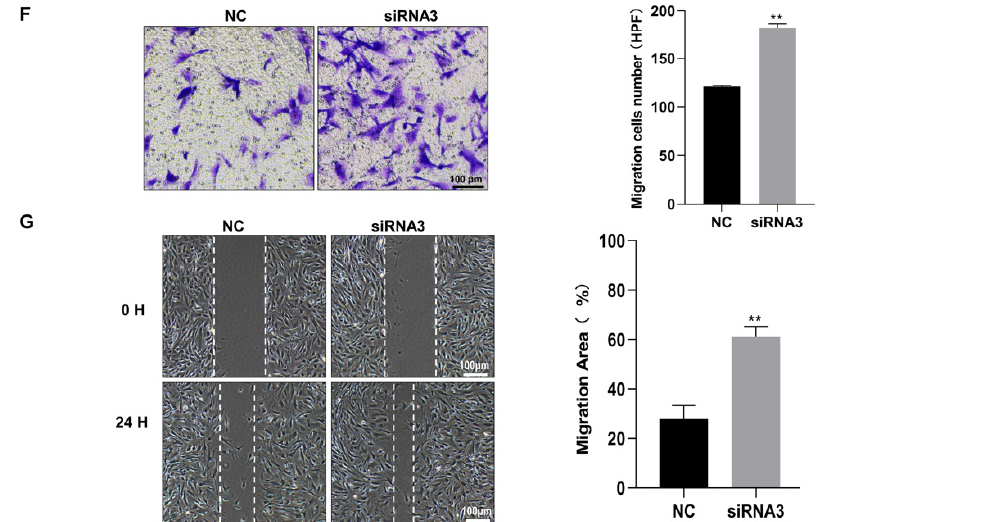
Figure 4. SLC6A6 knockdown induced VSMC dedifferentiation, proliferation, and migration. ( A ) qRT‑PCR and ( B ) Western blot analysis of SLC6A6 mRNA and protein levels in VSMCs transfected with negative control (NC) or SLC6A6 siRNAs (siRNA 1, siRNA 2, or siRNA 3; 100nmol/L), respectively. Data are normalized to GAPDH for qRT‑PCR, data are normalized to β ‑actin for Western blotting; N = 3; * p < 0.05, ** p < 0.01 vs. NC. Data are represented as mean ± SD. ( C ) Western blot analysis of SLC6A6, SMMHC, α ‑SMA, SM22 α , and cyclin D1 after siRNA3 transfection. Data are normalized to β ‑actin; N = 3; * p < 0.05, ** p < 0.01 vs. NC. Data are represented as mean ± SD. ( D ) CCK‑8 and ( E ) EdU assays showing VSMC proliferation after siRNA3 transfection. Scale bar: 100 µ m (200 × ). N = 3; * p < 0.05, ** p < 0.01 vs. NC. Data are represented as mean ± SD. ( F ) Transwell assays and ( G ) wound‑healing assays showing VSMC migration after siRNA3 transfection for 24 h. N = 3; scale bar: 100 µ m (100 × ). HPF, high power field.; N = 3; * p < 0.05, ** p < 0.01 vs. NC. Data are represented as mean ±